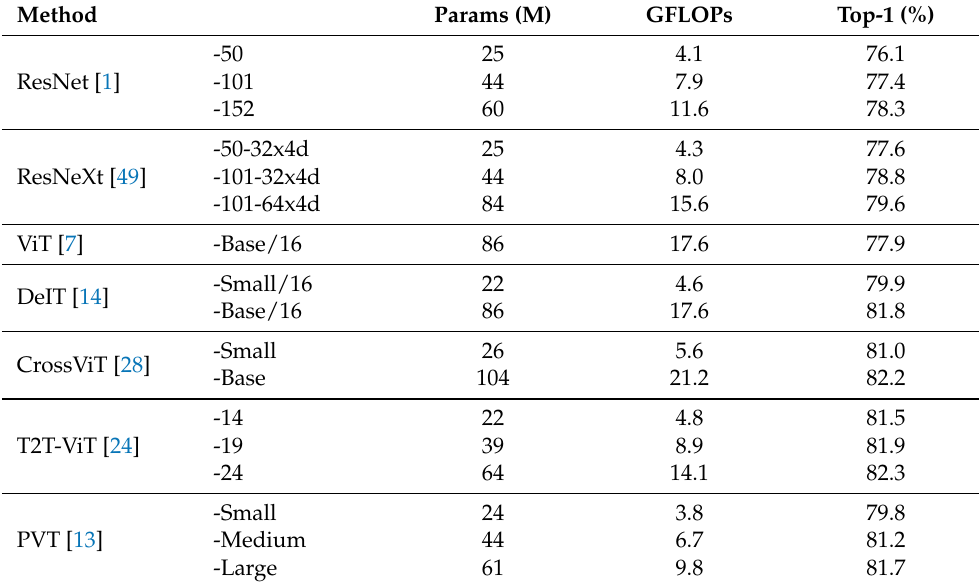
Table 1. Comparison of Top-1 image classification accuracy on the ImageNet-1K [21] validation set. Params refers to the number of parameters in millions and GFLOPs are calculated at a resolution of 224 2 . Our networks are highlighted in gray. 7 refers to a global window of size 7 2 . All values are taken from the official